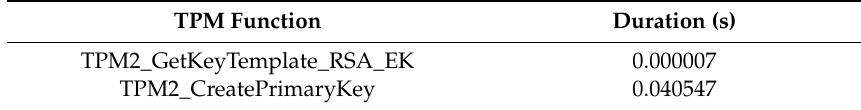
Table 1. Measurements of the executed trusted platform module (TPM) functions for primary key